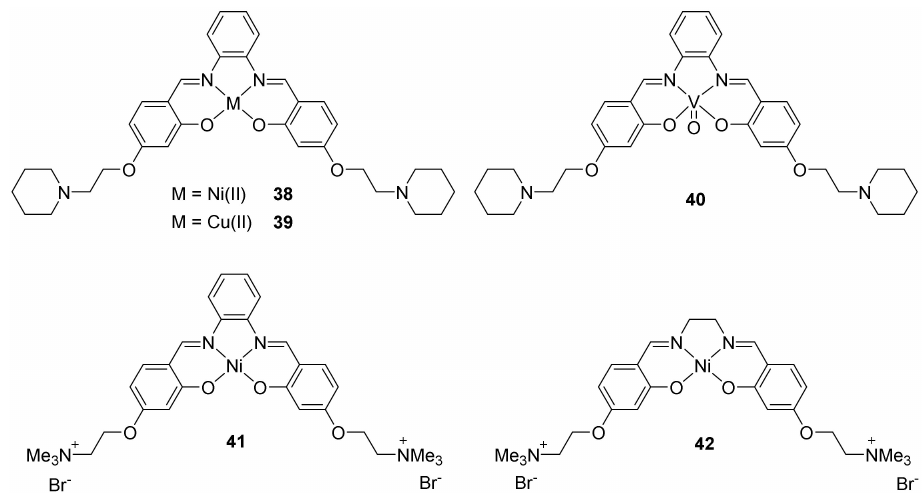
Figure 10. Structure of metalled salphen and salen complexes used for G-quadruplexes